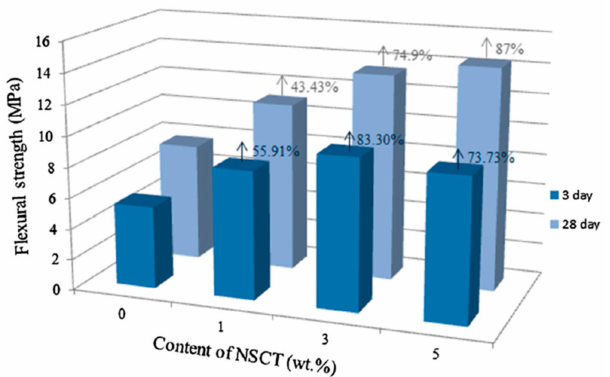
Figure 3. Flexural strength of NSCTRRPC test specimens with di ff erent values of NSCT content at curing age of 3 and 28 days. Reprinted with permission from [80]. Copyright © 2017, Elsevier